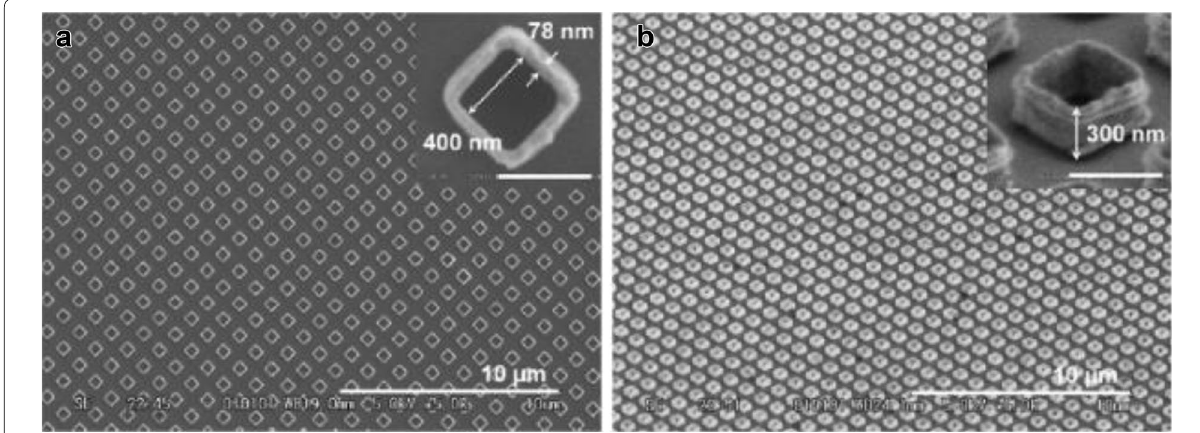
Fig. 3 a Top and b 60°-tilted SEM images of large-area integrated Au nanobox arrays with a 400 nm inner square. The bilayer polymer was imprinted by UV-NIL with a 400 nm square pattern and subjected to 5 min of Au deposition, 5 min of ion milling, and 10 min of piranha cleaning. The scale bar of the insets is 500 nm [48]